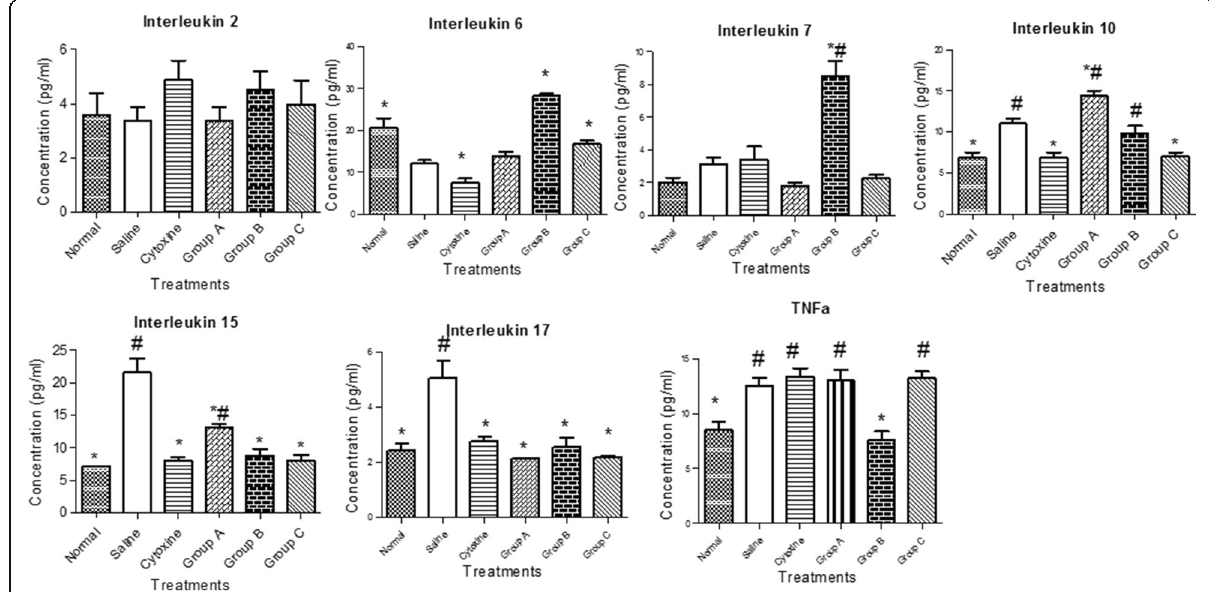
Fig. 2 Effect of Licorice polysaccharides on cytokine serum levels. Interleukin 2,6,7,10,15, 17 and TNF α . After treatment period, mice were sacrificed and cytokine levels measured by magnetic bead panel assay. Data represented as mean ± S.D. * p ˂ 0.05 versus the Saline group, # p ˂ 0.05 versus Normal